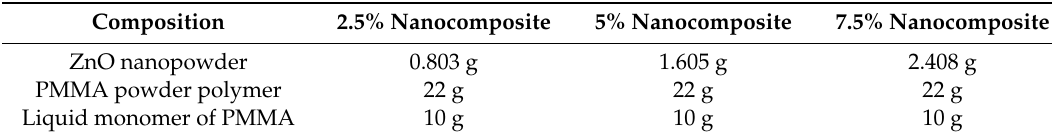
Table 1. Composition of particular